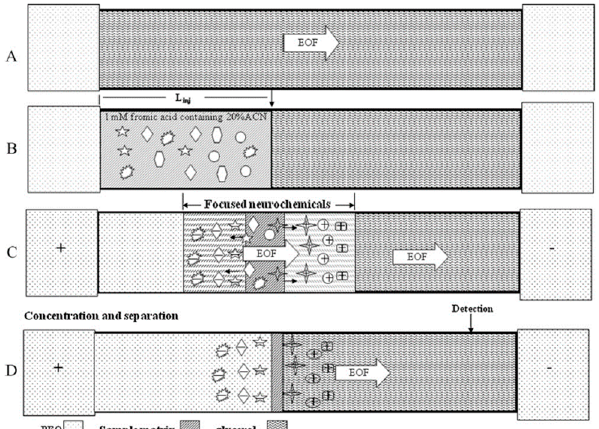
Figure 10. Evaluation of analyte zone in the separation and stacking of neurochemicals. ( A ) Filling of capillary with 500 mM TB (pH 9) containing different concentration of glycerol; ( B ) injection of a large volume of analytes solution; ( C ) stacking of twelve analytes by glycerol and PEO; ( D ) separation of the stacking cationic and anionic neurochemicals by glycerol and PEO. The µ EOF and µ EP present the EOF mobility and the electrophoretic mobilities of cationic and anionic neurochemicals, respectively. Scheme adopted from reference [98] with the copyright permission.